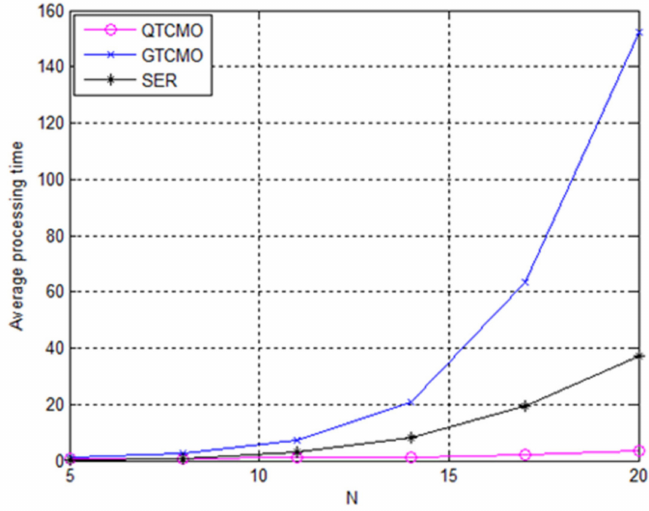
Figure 8. Average processing time for different N